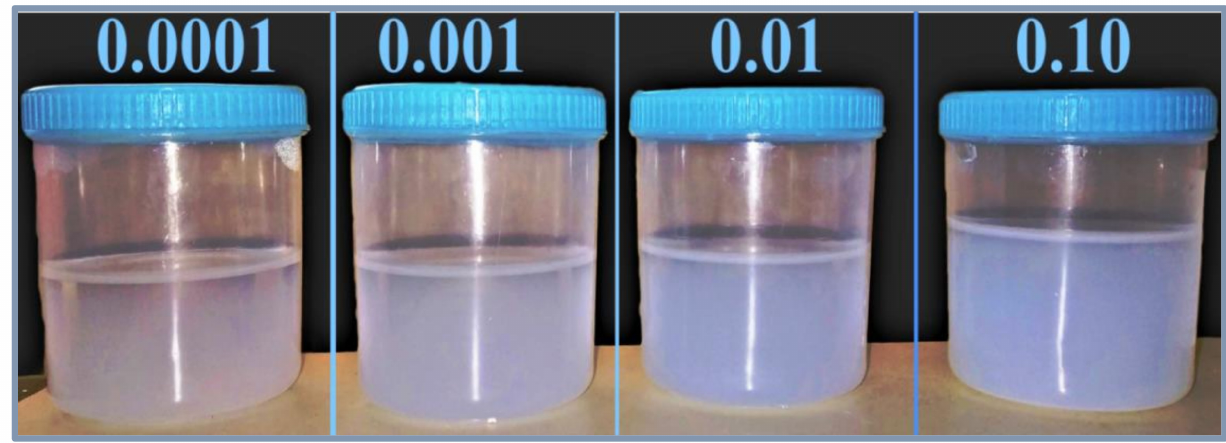
Figure 6. Images of the as-prepared SiO 2 –water nanofluid samples.